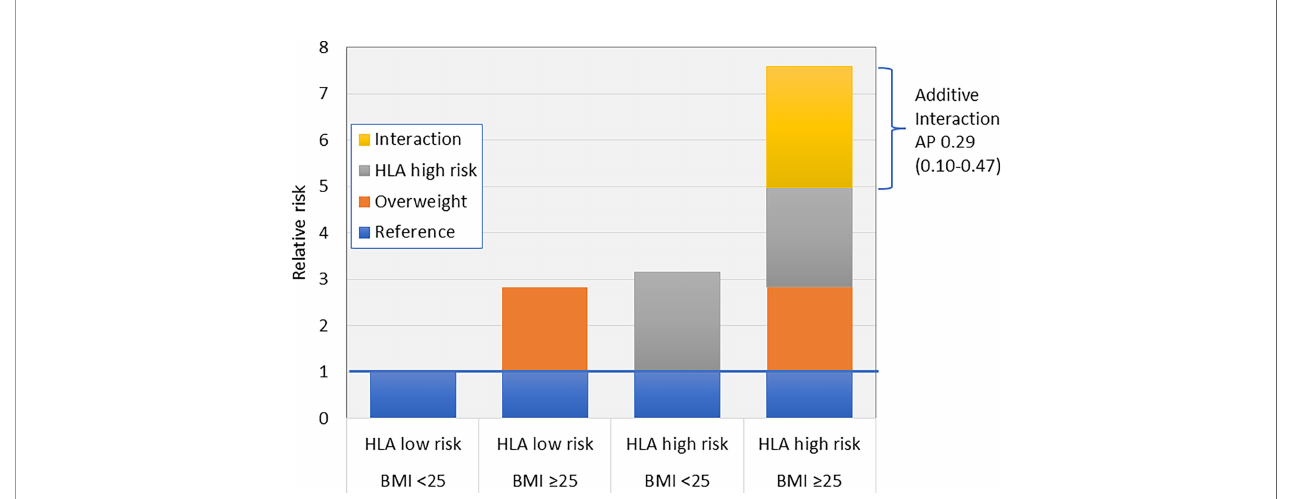
FIGURE 3 | Additive interaction between HLA risk genotypes and overweight (BMI >25) on the risk of LADA (28). AP, Attributable proportion due to interaction.